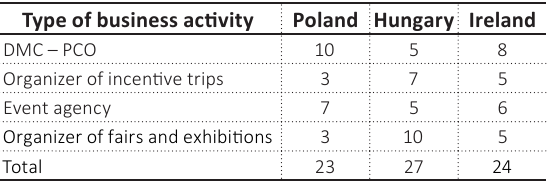
Source: Own study.